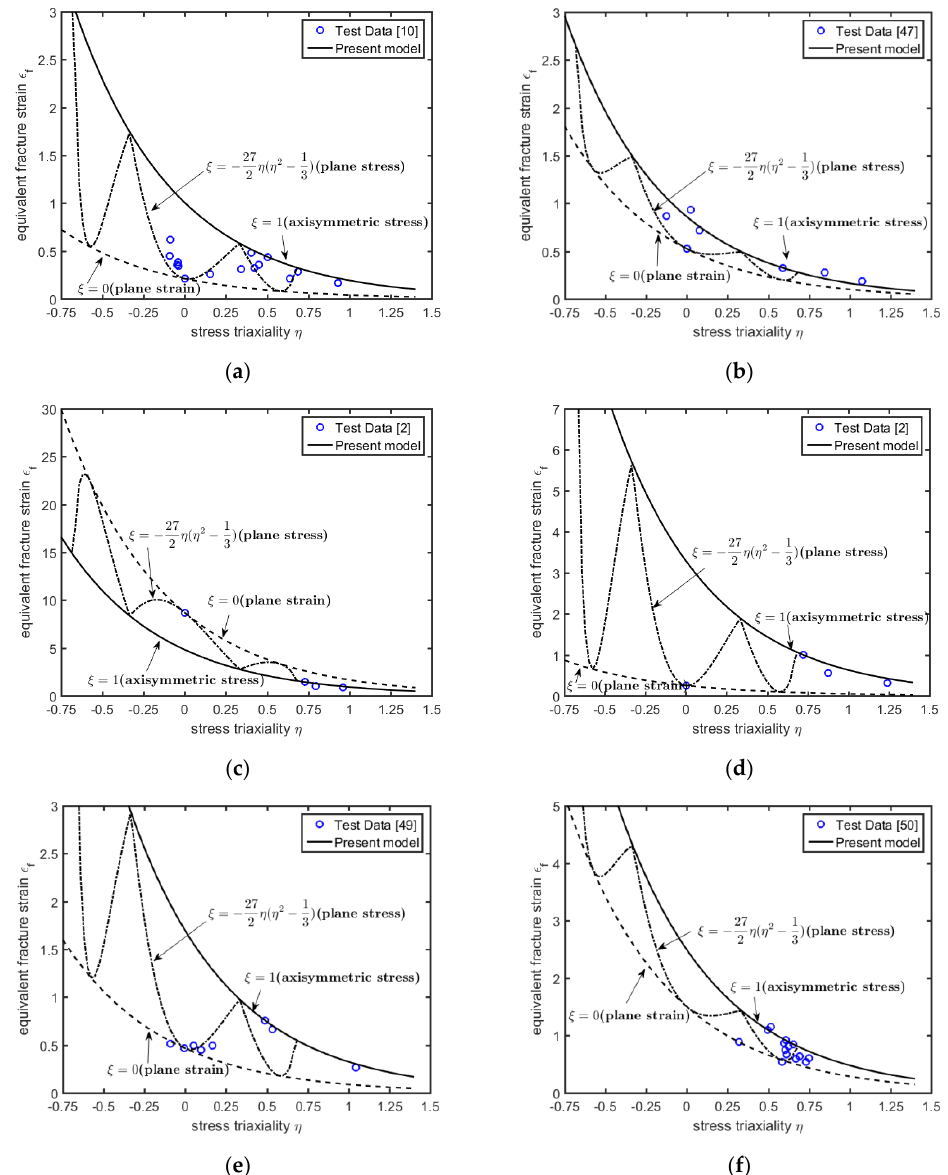
Figure 14. Dependence of the equivalent strain to fracture on the stress triaxiality on some metals: ( a ) 2024-T351 Al; ( b ) 6061-T6 Al; ( c ) OFHC copper; ( d ) 4340 steel; ( e ) Ti-6Al-4V alloys; and ( f ) Q235 mild steel.